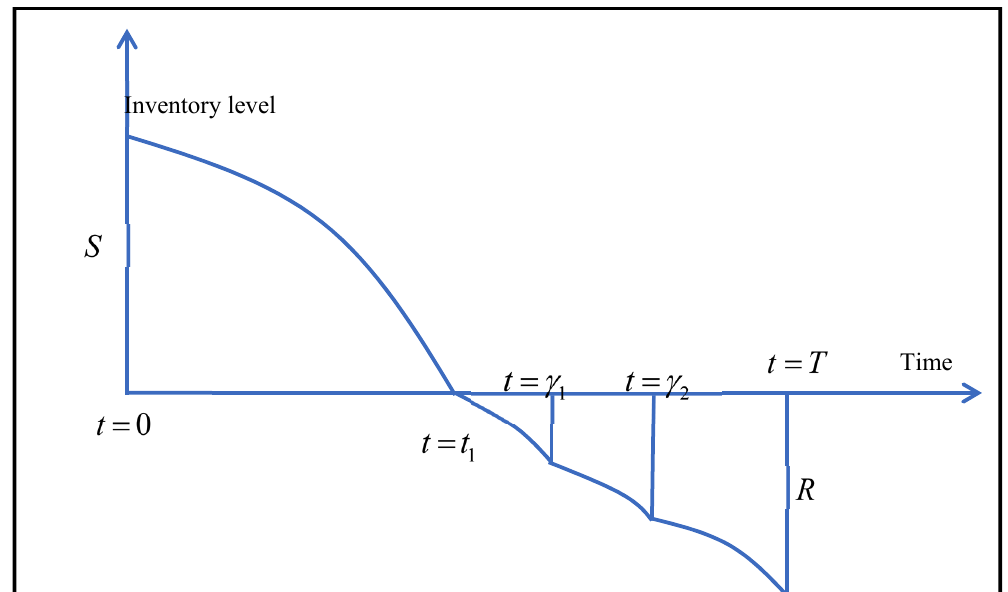
Figure 2. Pictorial representation of inventory situation under Case-I.